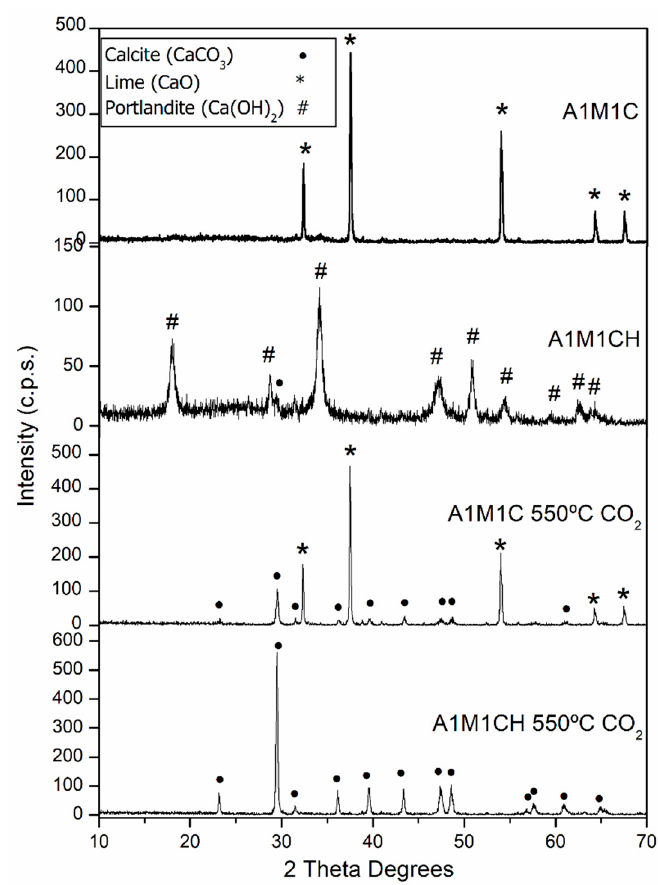
Figure 8. X-ray diffraction (XRD) patterns of the samples A1M1C and A1M1CH and the samples A1M1C and A1M1AC heated at 550 °C in a tubular oven with a CO 2 flow of 20 mL min − 1 .